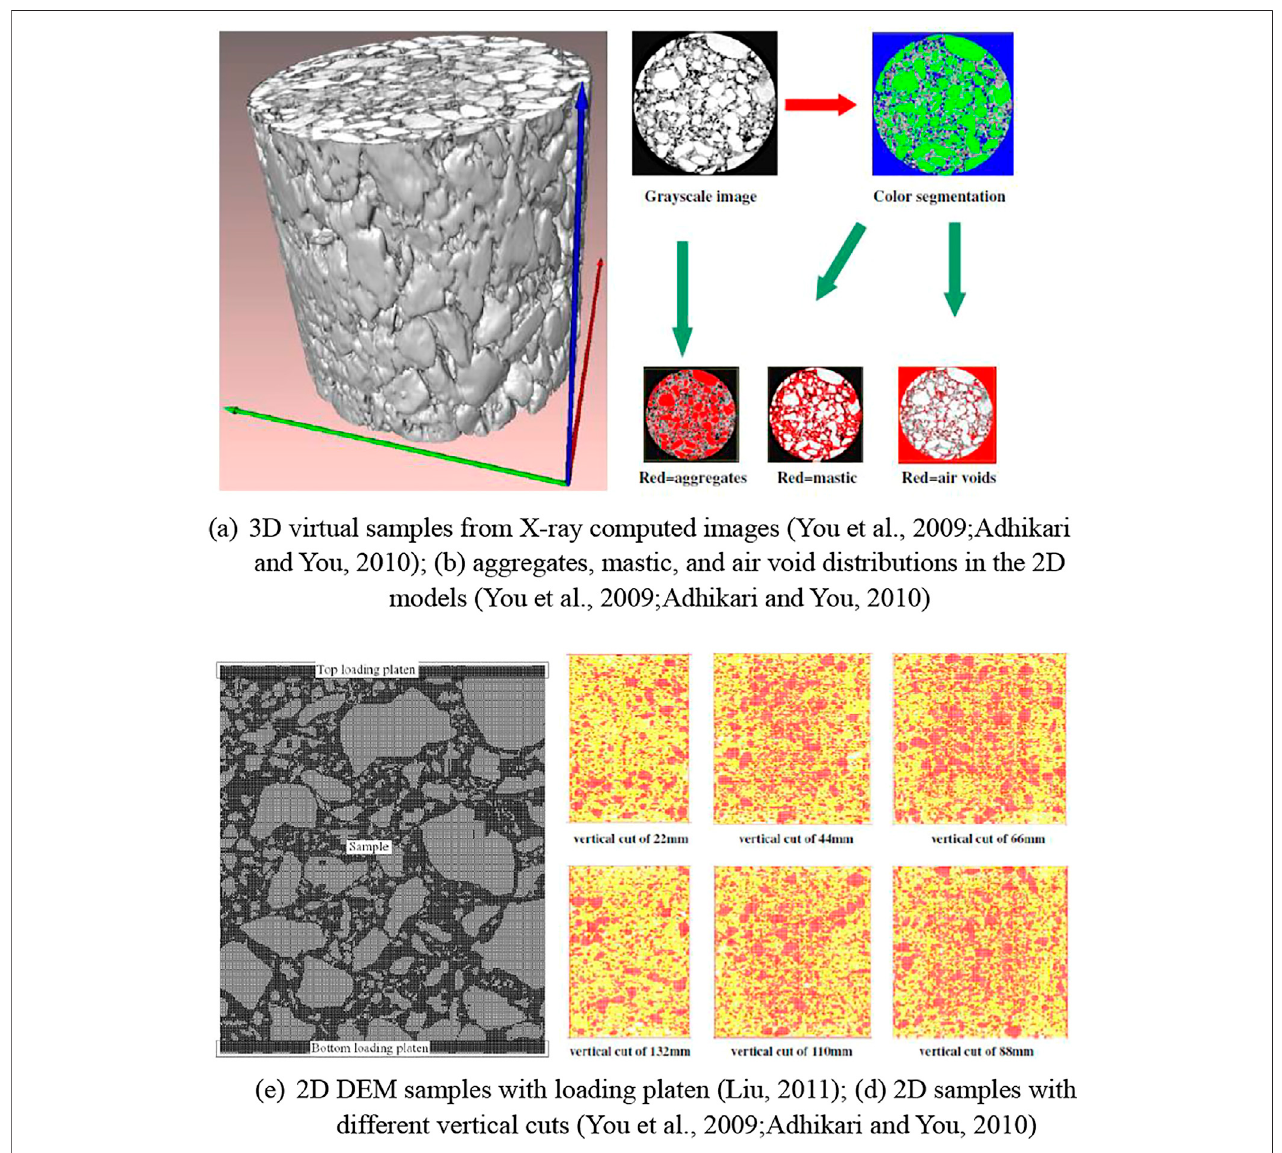
FIGURE 7 | Virtual samples of the asphalt mixtures (Liu, 2011; You et al., 2009; Adhikari and You, 2010). (A) 3D virtual samples from X-ray computedimages (You et al.,2009;AdhikariandYou,2010); (B) aggregates,mastic,andairvoid distributions inthe2D models(You et al.,2009;Adhikariand You,2010). (C) 2DDEM samples with loading platen(Liu, 2011); (D) 2D samples with different vertical cuts(You et al., 2009; Adhikari and You, 2010).